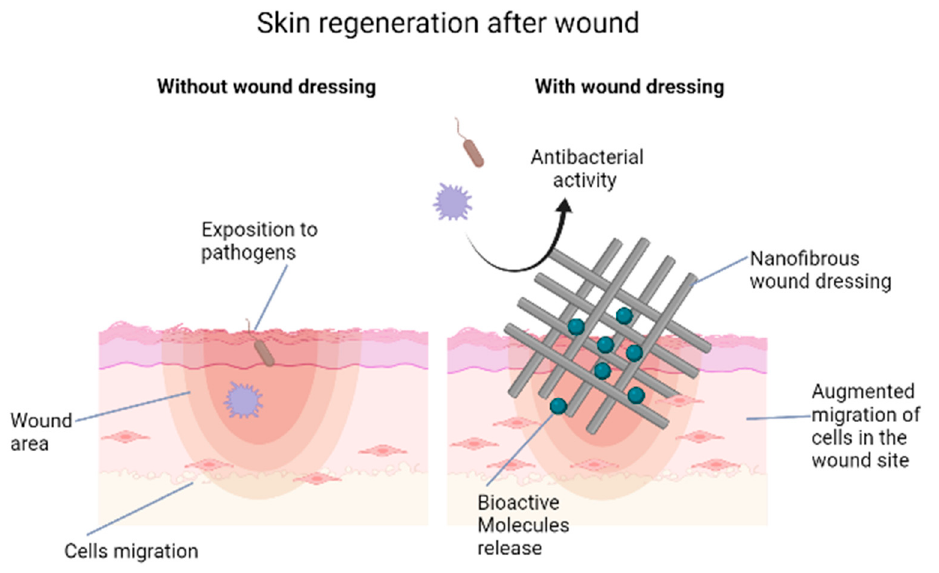
Figure 2. Skin regeneration after wound process with or without wound dressing. The nanofibers mimic the ECM and provides a proper environment for tissue growth, promoting re-epithelialisation and cell migration. They can be used in combination with bioactive molecules (functionalization) improving cell adhesion and proliferation, showing also antimicrobial activity.